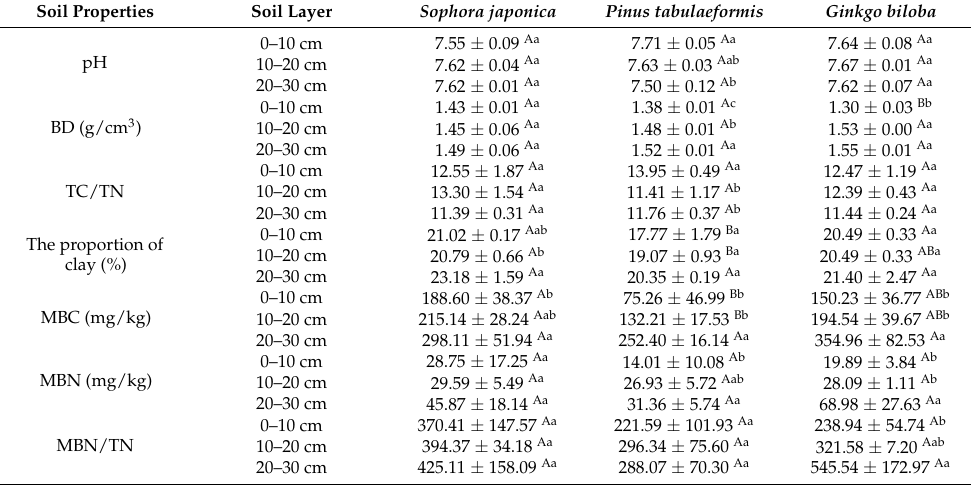
Table 2. Physicochemical properties of soils collected from different soil layers under three tree species